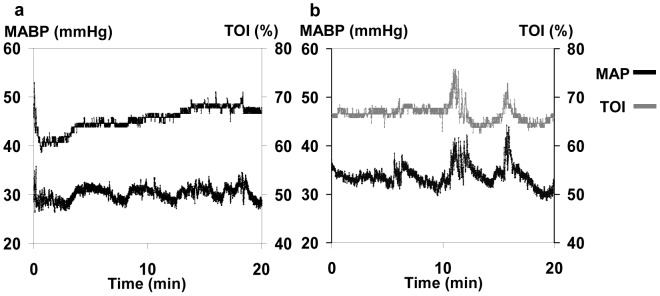
Coh between MABP and TOI.(a) Low Coh between MABP and TOI. Despite fluctuations in MABP, TOI remains relatively unchanged, indicating intact autoregulation. The Coh value in the 0.003–0.02 Hz frequency range is 0.40. (b) High Coh between MABP and TOI. Note the concordant fluctuations in MABP and TOI waveforms suggesting impaired autoregulation; Coh is 0.66.